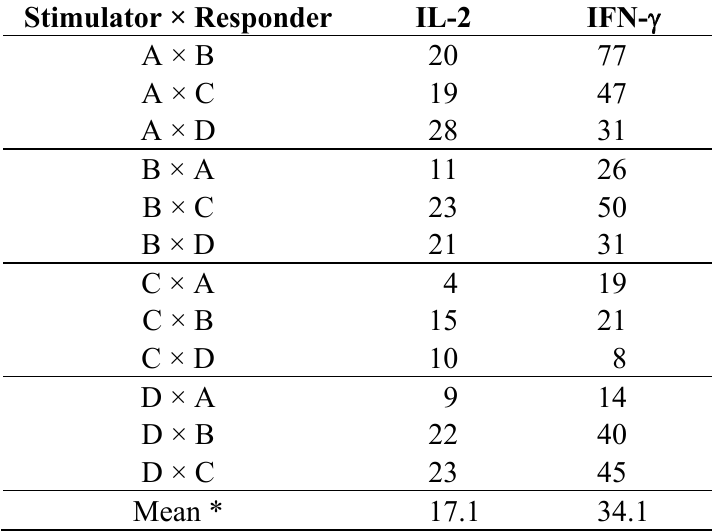
Table 1. IFN-  frequency dominates during first 20 h of allogeneic